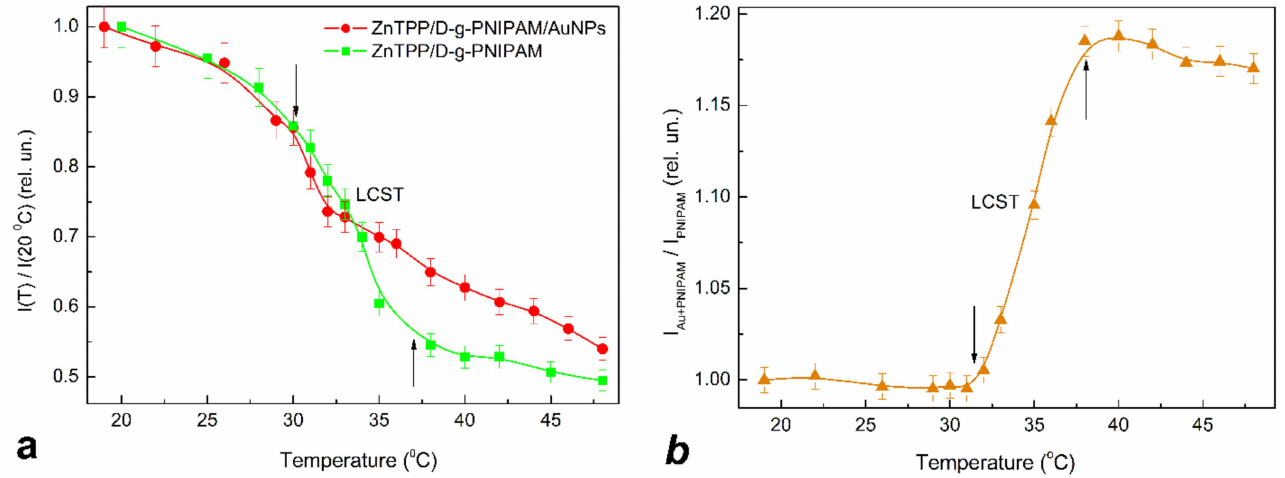
Figure 8. ( a )—Temperature dependence of total FL intensity for aqueous solutions of ZnTPP/D-g- PNIPAM (squares) and ZnTPP/D-g-PNIPAM/AuNPs (circles) during heating. ( b )—Temperature dependence of the ratio of total FL intensities for ZnTPP/D-g-PNIPAM/AuNPs and ZnTPP/D-g- PNIPAM characterizing the impact of Au NPs on FL of ZnTPP in ZnTPP/D-g-PNIPAM/AuNPs nanosystem. The FL intensity is normalized by value at 20 ◦ C. Arrows show the LCST transition range. Concentrations: ZnTPP—0.001 g/L, D-g-PNIPAM—0.078 g/L, Au—0.077 g/L. The observed behavior of the temperature dependences of absorption and FL in the temperature region of LCST transition can be caused by three physical mechanisms.